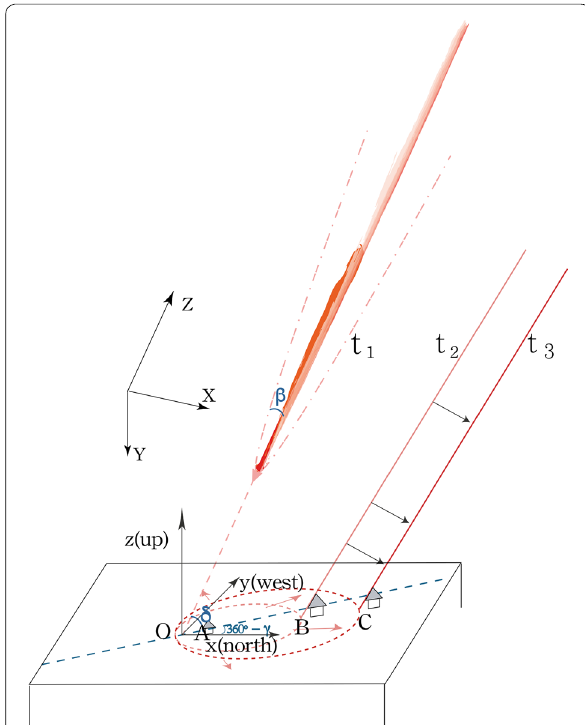
Fig. 5 The time-compressed schematic of the meteor trajectory. The two rectangular coordinate system ( x , y , z ) and ( X , Y , Z ; Z indicates the direction of approaching meteor) constrains the geographical and meteoric trajectory location in space, respectively. The dashed , thin , and bold red line segments represent the plane shockwaves location at time t 1 , t 2 , and t 3 , respectively ( t 3 > t 2 > t 1 ). The light and bold red-dashed ellipses approximately demarcate the region having relatively higher signal amplitude at time t 2 , and t 3 , respectively. The stations closer to the intercept of the protracted trajectory with the ground (termination point; O) encounter earlier shockwave arrival. δ , β , and γ are the elevation angle, the Mach angle, and the azimuth of the trajectory, respectively. The azimuth ( γ) is the angle measured from the geographic north to the horizontal projection of the Z-axis in the x–y plane, in the clockwise direction. The elevation angle ( δ) is the minimum angle between the Z-axis (direction of approaching meteor) and the x–y plane